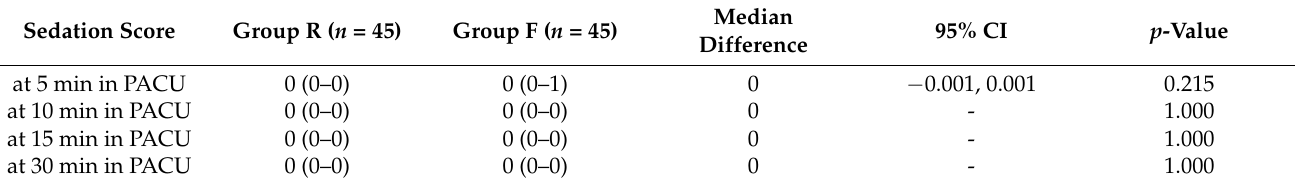
Table 5. University of Michigan Sedation Scale scores.